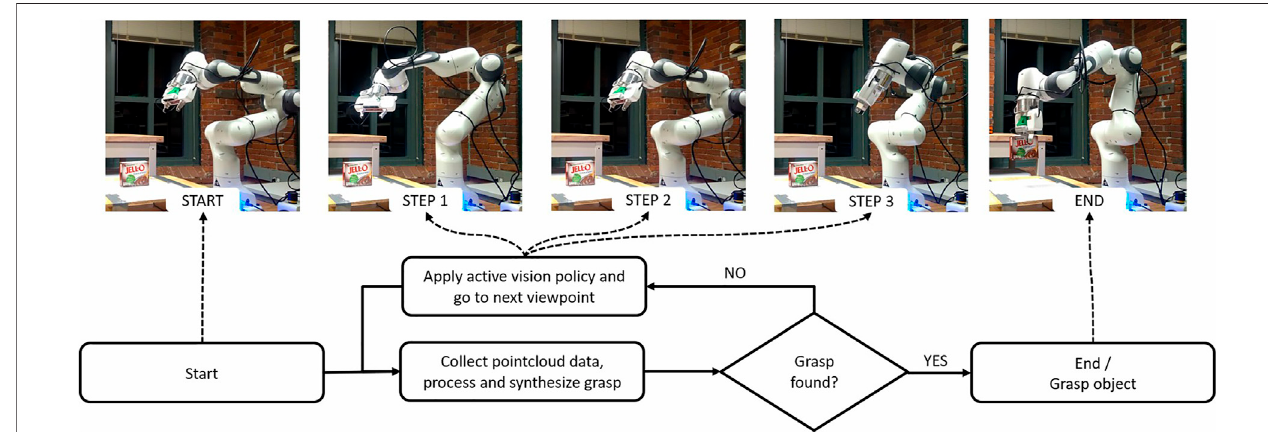
FIGURE 1 | The 3D Heuristic policy guiding the camera and fi nding the grasp for a